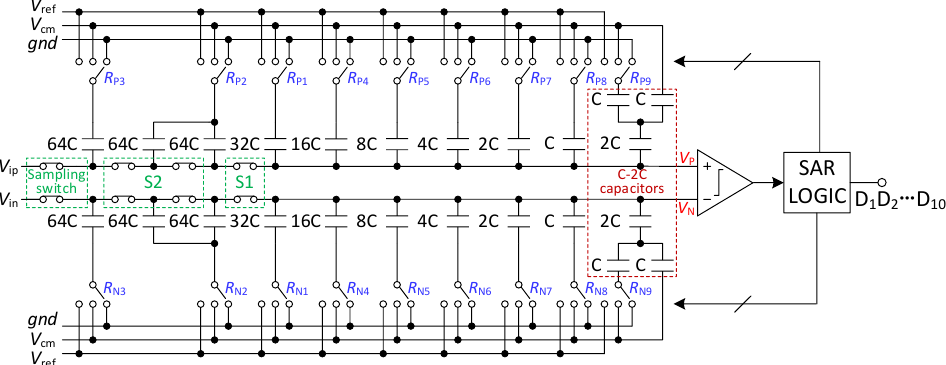
Figure 1. Architecture of 8 – 10-bit resolution-reconfigurable SAR ADC.